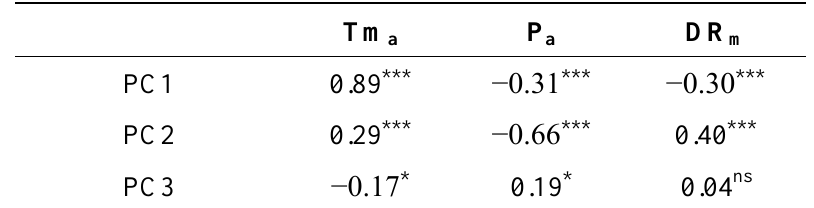
Table 2. Correlations between floristic gradients (PC1, PC2, and PC3) and main climatic variables (Tm = mean annual temperature, P a temperature range). Asterisks indicate the significance level (*** < 0.0001 < ** < 0.001 < * < 0.05 < . < 0.1 < ns).